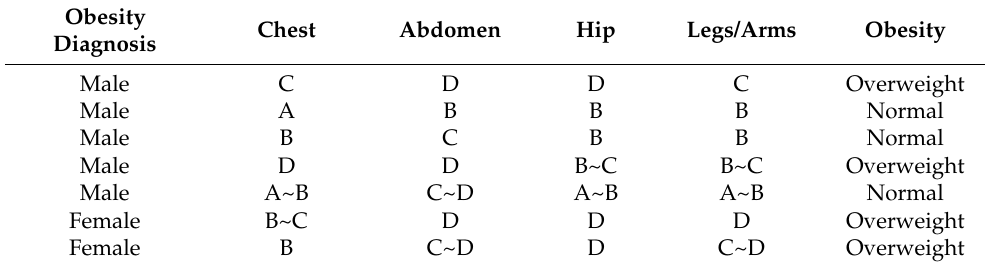
Table 8. Exceptions by group for males and